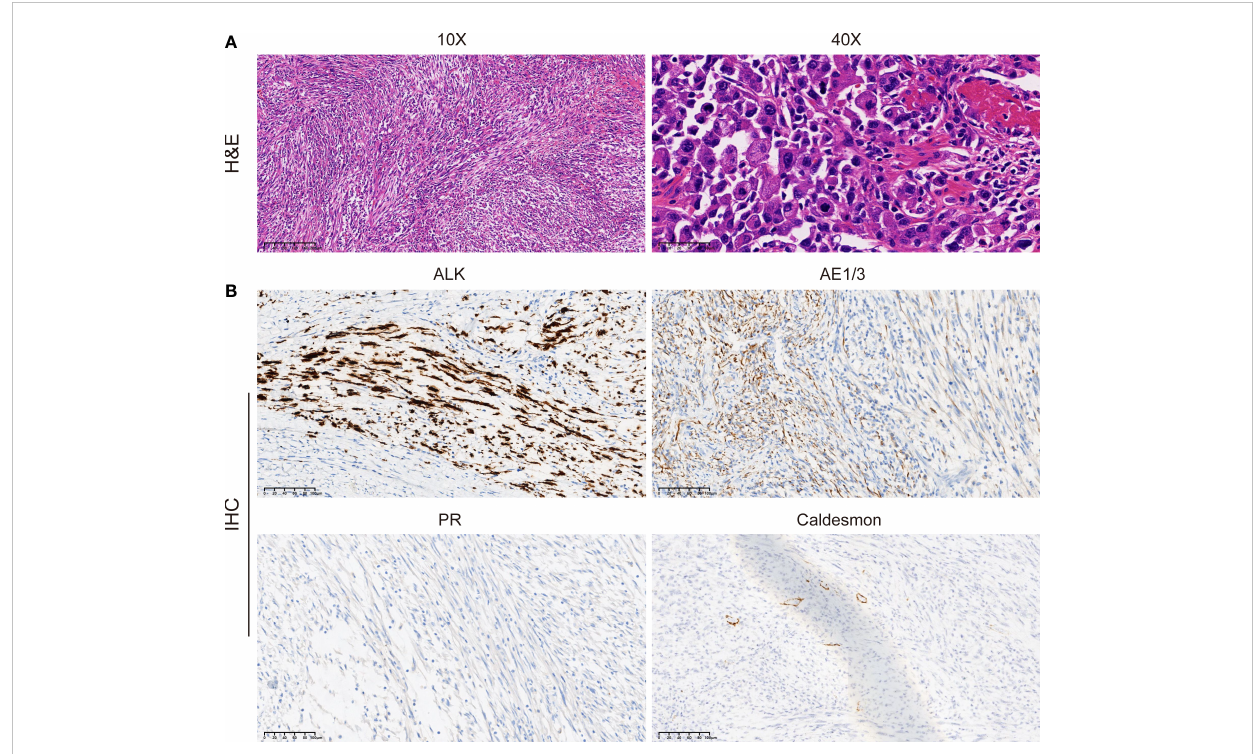
FIGURE 2 Morphologic features and IHC staining of the uterine IMT samples. Representative pictures of H&E staining (A) and IHC analysis (B) of ALK, AE1/3, PR, and caldesmon expression levels in uterine IMT. Scale bars are illustrated in the pictures. IHC, immunohistochemistry; IMT, in fl ammatory myo fi broblastic tumor; H&E, hematoxylin, and